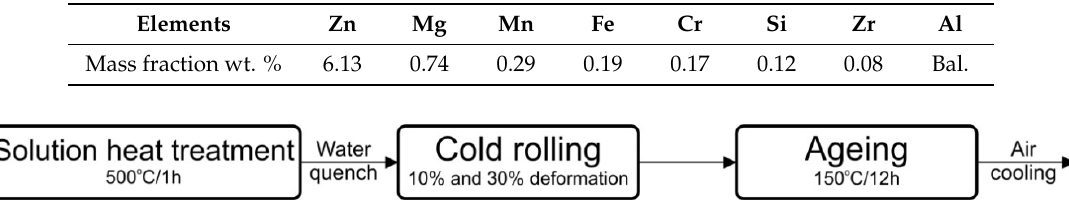
Table 1. Chemical composition of the investigated alloy.